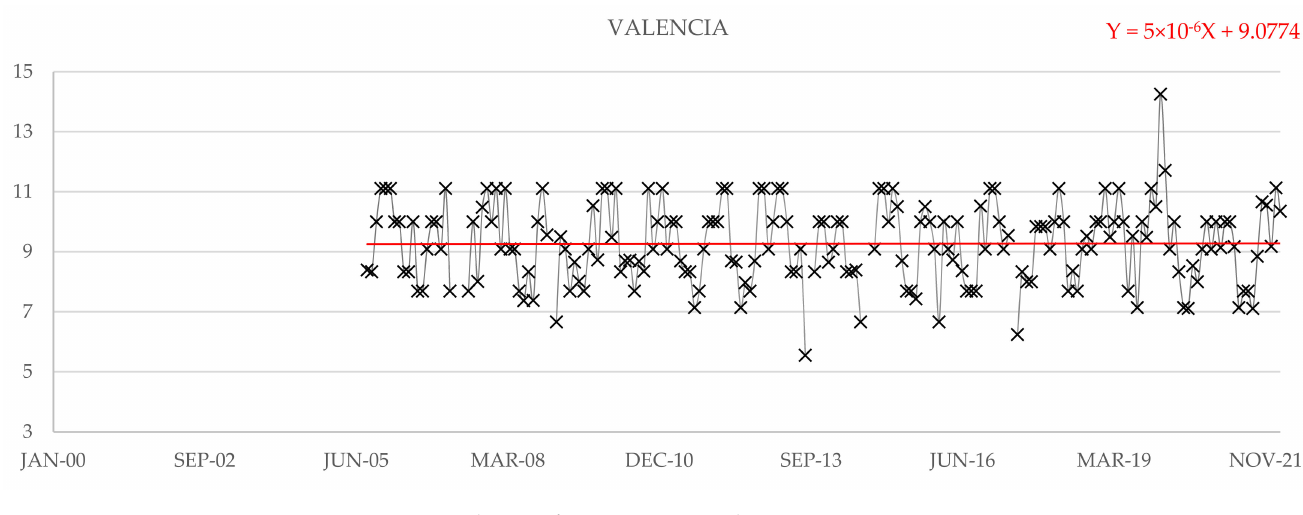
Figure 15. Evolution of Tp maxima in Valencia.